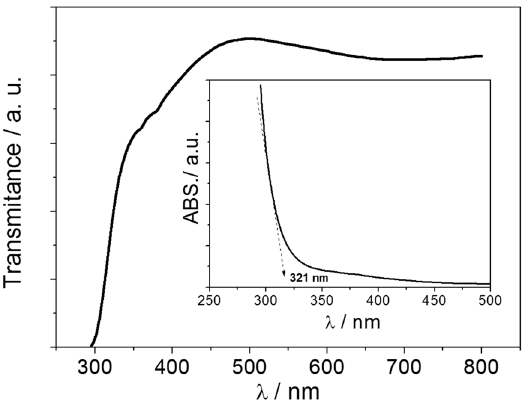
Figure 2. Transmission spectrum of the synthesized ITO film. Inset: Absorption spectrum of the same film.